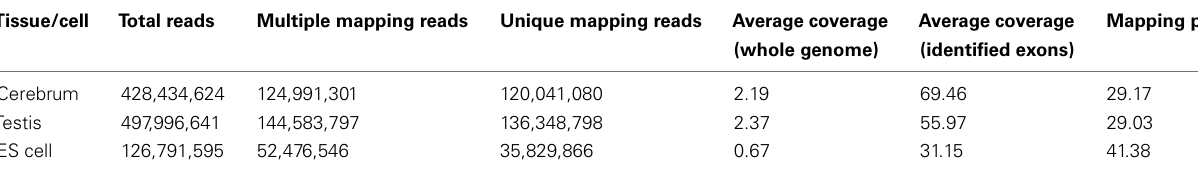
TableA1 |The sequence mapping summary of rmRNA-seq data.